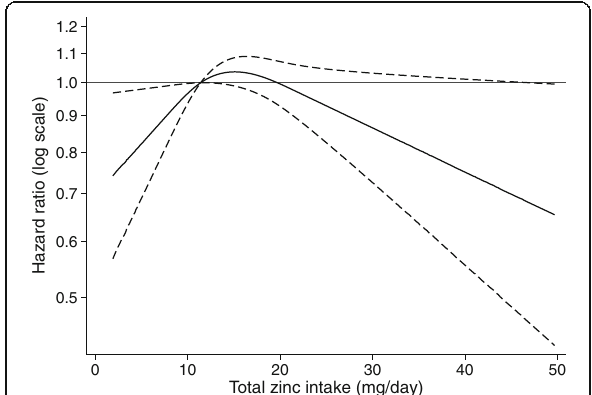
Fig. 1 Restricted cubic spline representing the association between total zinc intake and risk of type 2 diabetes in the Malmö Diet and Cancer Study ( n = 26,132). Median total zinc intake (11.4 mg/day) was used as the reference point. Bold line represents hazard ratio (HR), and dotted lines represent the 95% confidence interval. The spline was fitted using a BMI-stratified Cox proportional hazards model with attained age as the time metric and adjusting for dietary and non-dietary